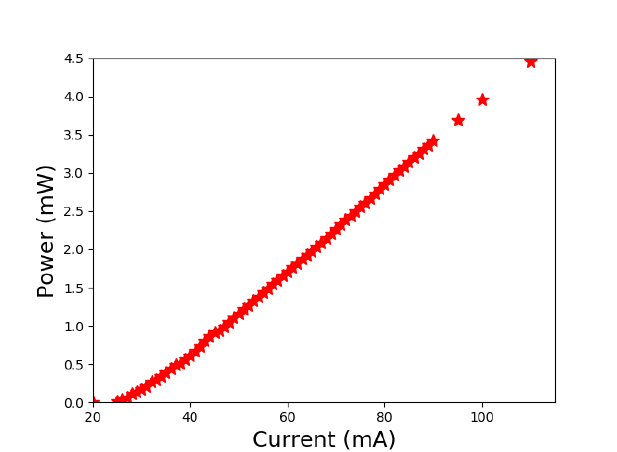
Figure 6. Measured Light-Current (LI) curve for the external cavity laser. Can see that threshold current is approximately 22mA and the output power from the laser is 4mW at 100mA for RSOA (Reflective Semiconductor Optical Amplifier) current. Slope efficiency of the laser is